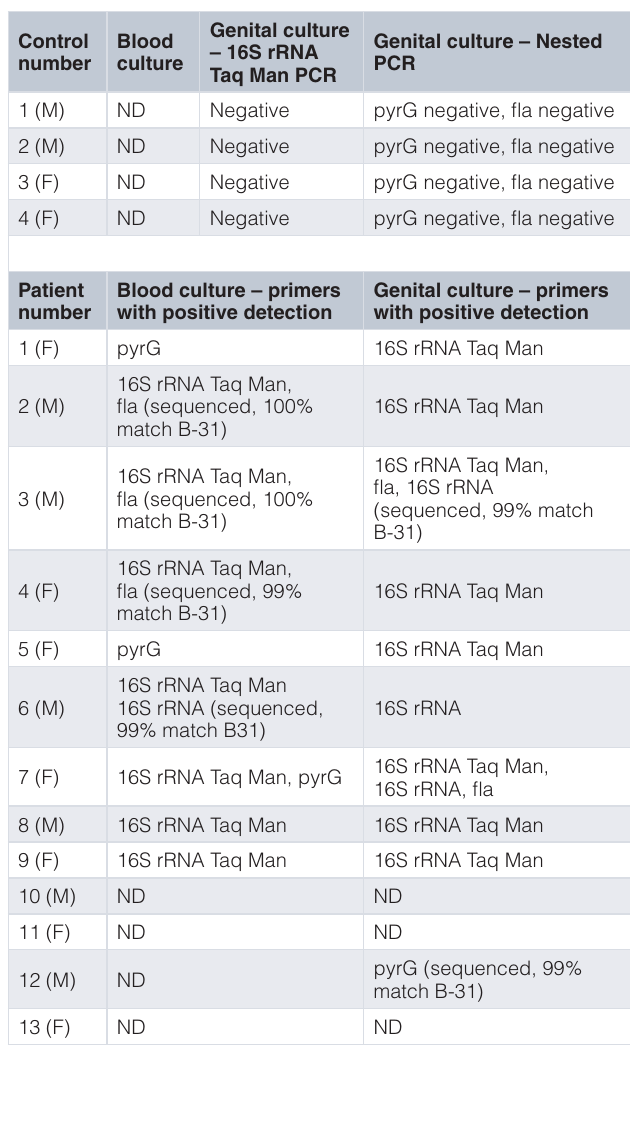
Table 5B: PCR – University of New